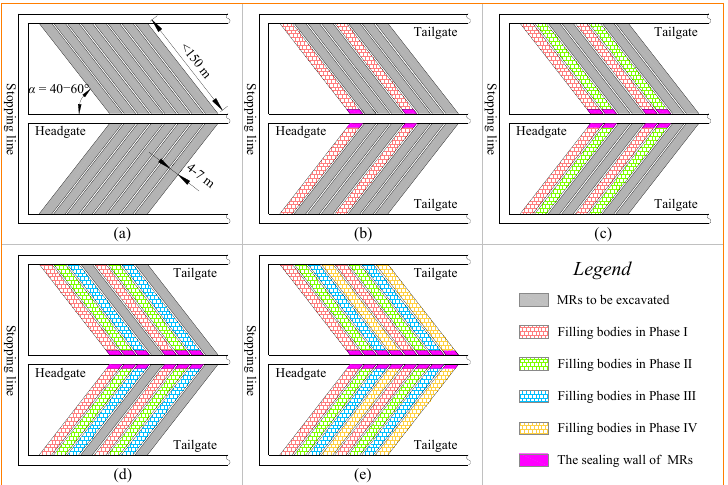
Figure 2. Schematic map of the mining process of CECB. ( a ) The layout of MRs; ( b ) MRs in the 1st mining phase have been excavated and filled; ( c ) MRs in the 2nd mining phase have been excavated and filled; ( d ) MRs in the 3rd mining phase have been excavated and filled; ( e ) MRs in the 4th mining phase have been excavated and filled.